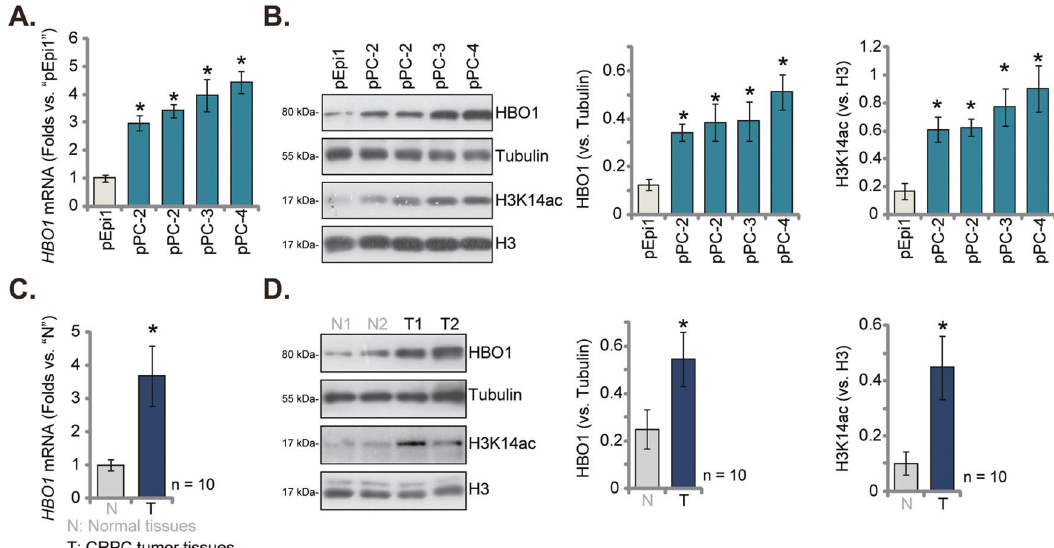
Fig. 6 HBO1 overexpression in CRPC cells and tissues. Expression of HBO1 mRNA ( A , C ) and listed proteins ( B , D ) in primary human prostate epithelial cells ( “ pEpi1 ” ), the listed primary CRPC cells ( “ pPC-1/pPC-2/pPC-3/pPC-4 ” ), the CRPC tumor tissues ( “ T ” , derived from 10 different CRPC patients, n = 10) or tumor-surrounding normal prostate tissues ( “ N ” ) were shown. Data were expressed as the mean ± standard deviation (SD). * P < 0.05 versus “ pEpi1 ” cells or “ N ”